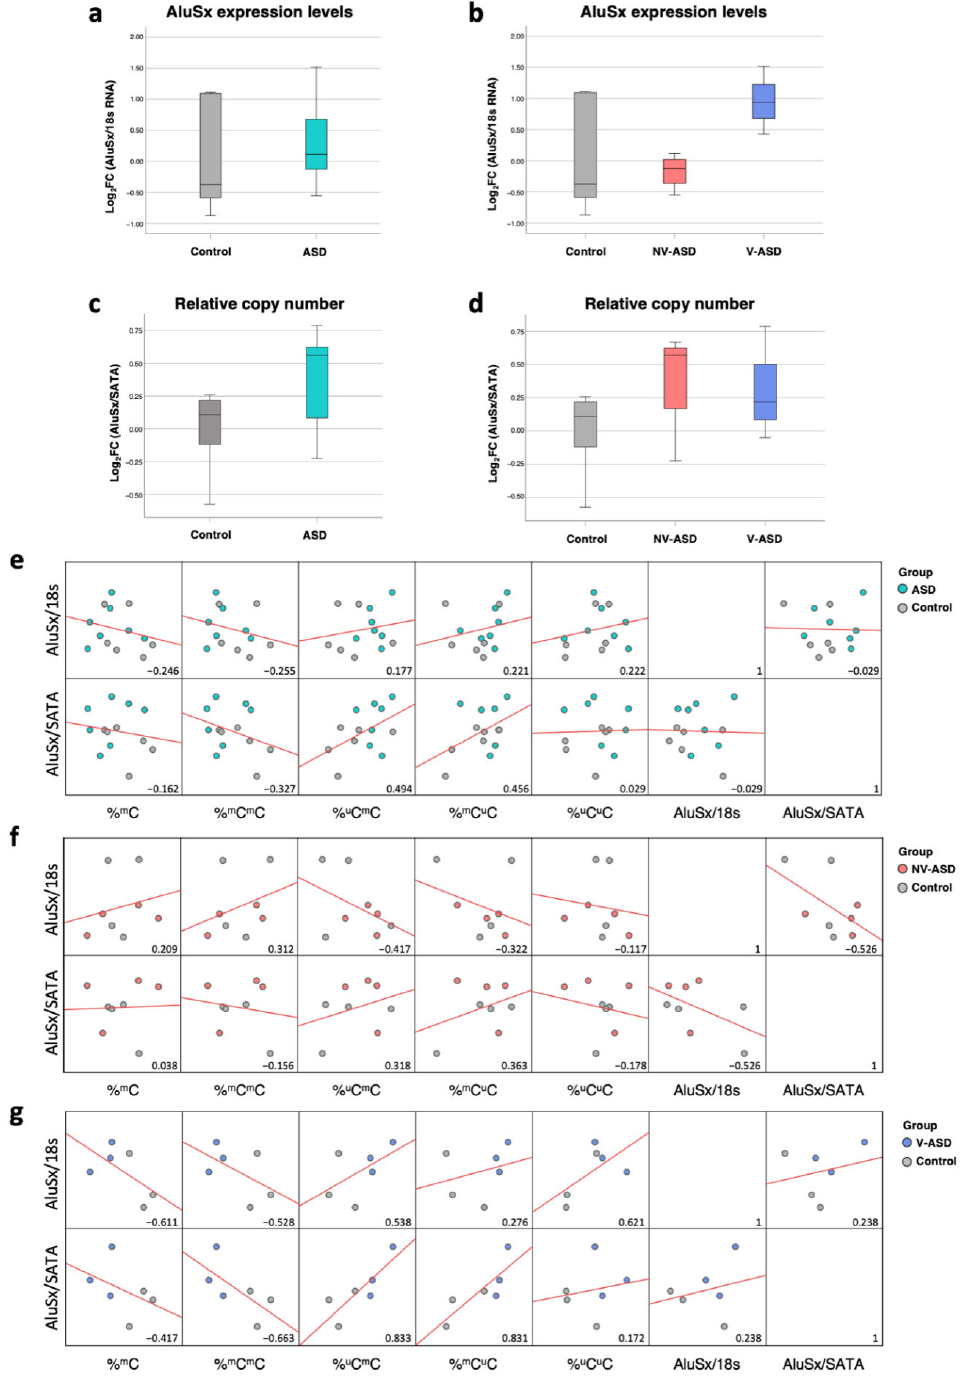
Figure 6. AluSx expression level and relative copy number in the prefrontal cortex of ASD individuals: ( a ) Box plot of AluSx expression levels in ASD and matched controls. ( b ) Box plot of AluSx expres- sion levels in ASD subtypes (NV-ASD and V-ASD) and matched controls. ( c ) Box plot of relative AluSx copy number in ASD and matched controls. ( d ) Box plot of relative AluSx copy number in ASD subtypes (NV-ASD and V-ASD) and matched controls. ( e ) Correlation matrix between DNA methylation, expression, and copy number of AluSx in ASD and matched controls. ( f ) Correlation between expression level and relative copy number and DNA methylation of AluSx in NV-ASD. ( g ) Correlation between expression level and relative copy number and DNA methylation of AluSx in V-ASD. Red lines in ( e – g ) represent trend lines (linear